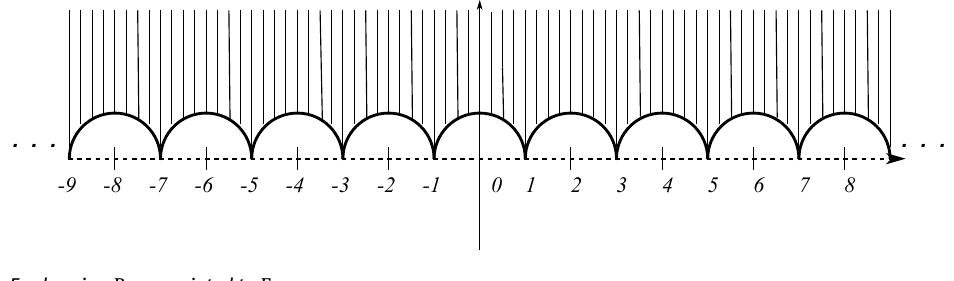
Figure 7: Ford region R 0 associated to Γ